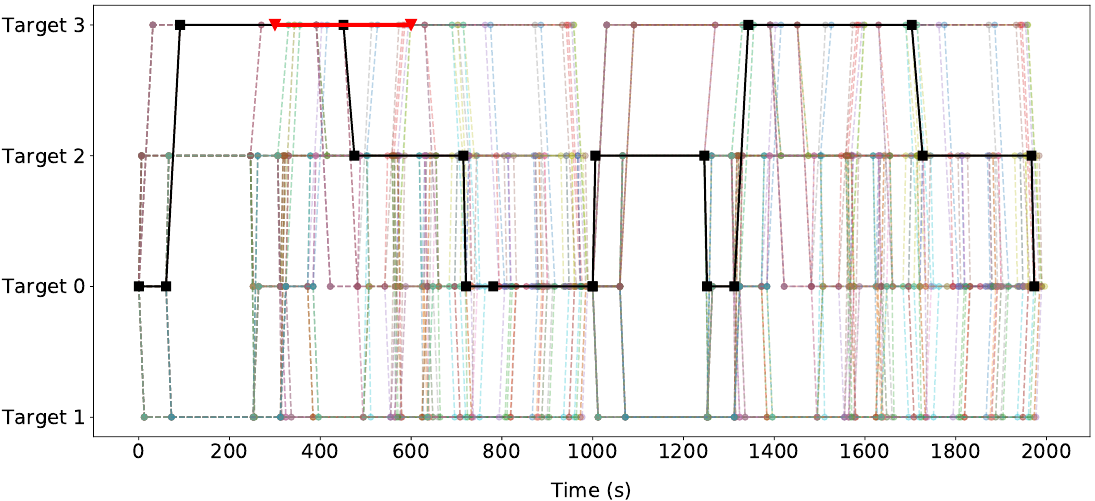
Figure 8. The deterministic optimal patrolling strategy over time and the attacker’s best response. The black lines symbolize the defender’s optimal patrolling strategy. The probability associated with each movement is